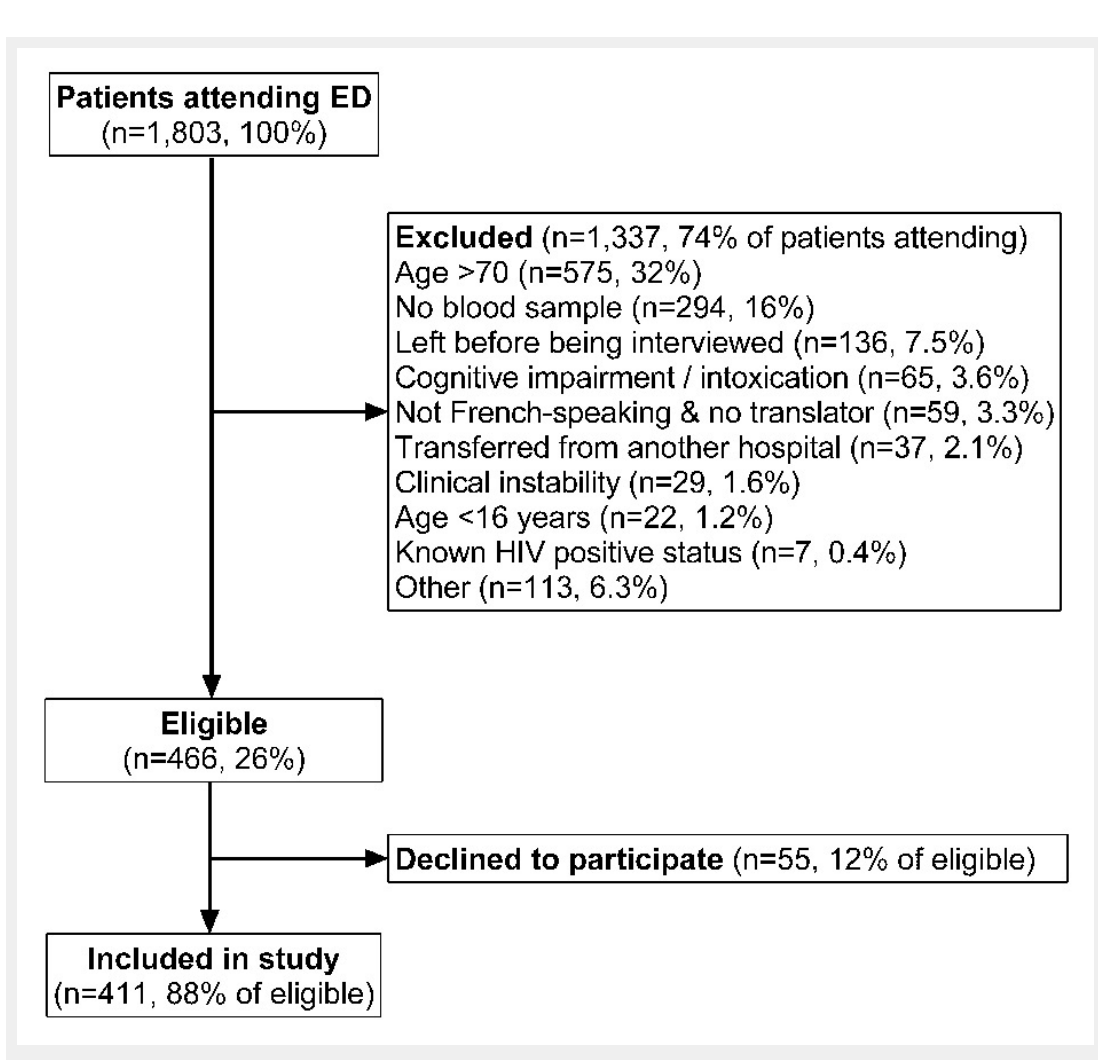
Figure 1 Flowchart of patients included in the study out of those attending the emergency department (ED) during 56 shifts of